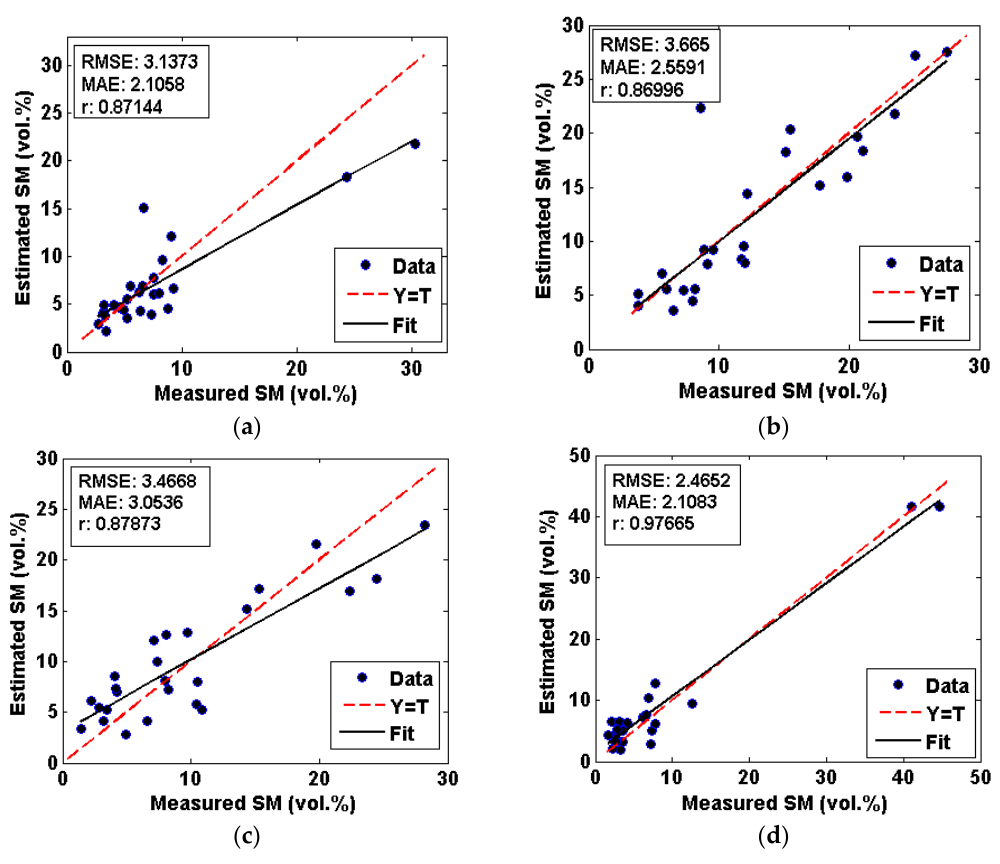
Figure 13. The relationship between measured and estimated SM over testing areas 1–4 for Dataset 3 ( a – d ), respectively.